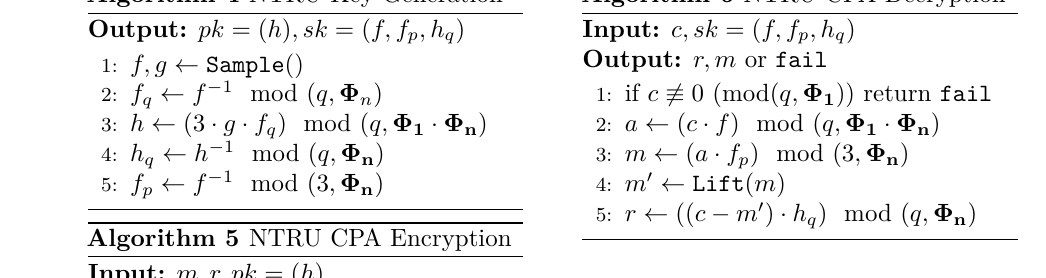
Algorithm 4 NTRU Key Generation